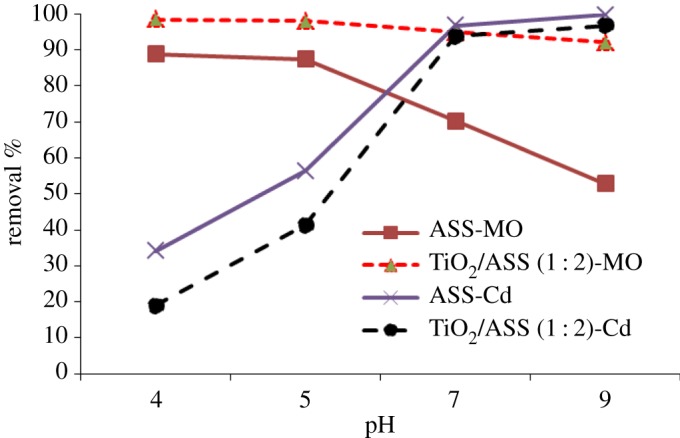
Effect of solution pH on MO and Cd2+ removal efficiency by ASS or TiO2/ASS (1 : 2).